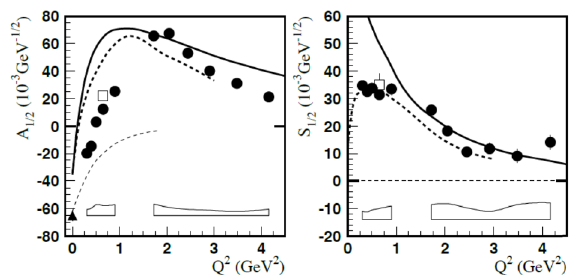
Figure 2. Helicity amplitudes for the γ ∗ p → N (1440) P 11 transi- tion. The full circles are the results obtained in [4] from CLAS data. The bands show the model uncertainties. The open boxes are the results of the combined analysis of CLAS single π and 2 π electroproduction data [7]. The full triangle at Q 2 = 0 is the Re- view of Particle Physics (RPP) estimate [8]. The thick curves correspond to the results obtained in the LF relativistic quark models assuming that N(1440) P 11 is a first radial excitation of the 3-quark ground state: [9] (dashed), [10] (solid). The thin dashed curves are obtained assuming that N(1440) P 11 is a glu- onic baryon excitation ( q 3 G hybrid state)